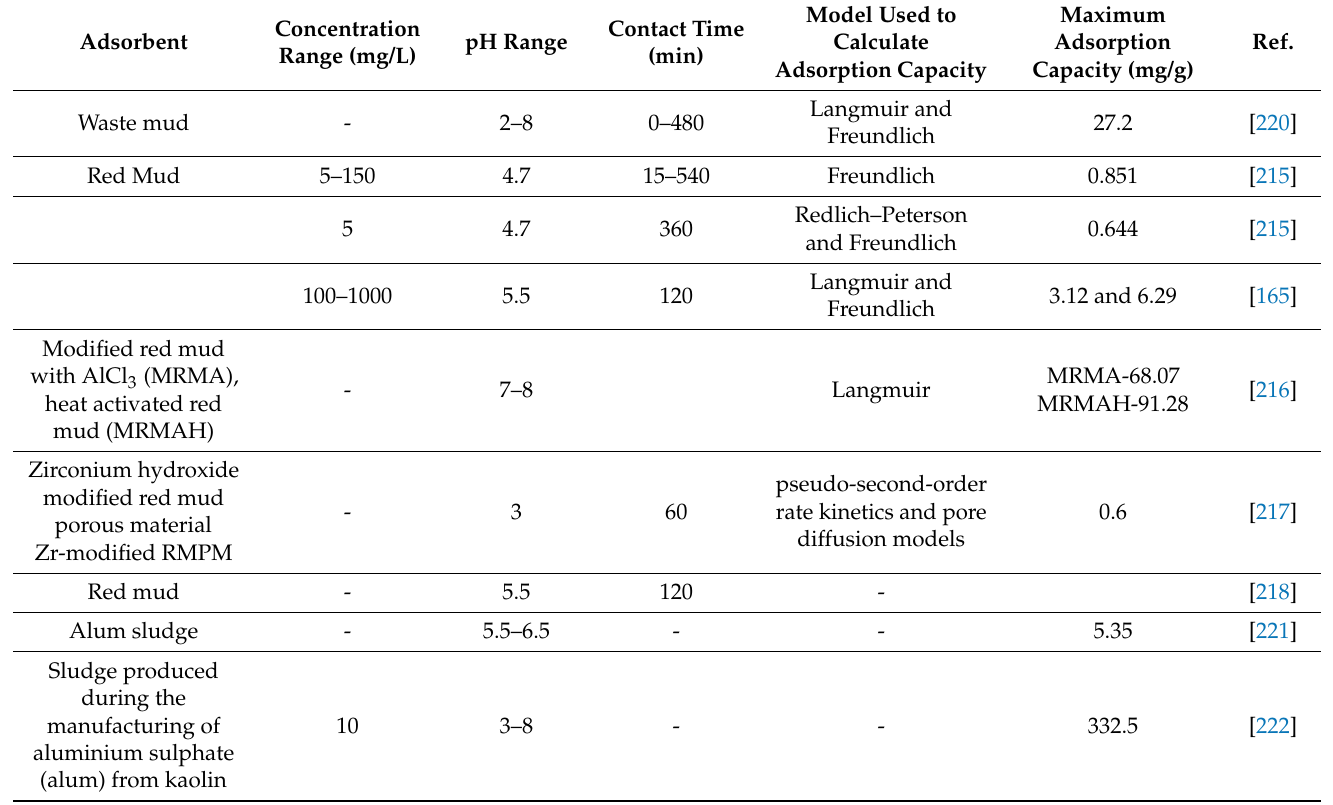
Table 2. Detailed information on the adsorbents used for fluoride